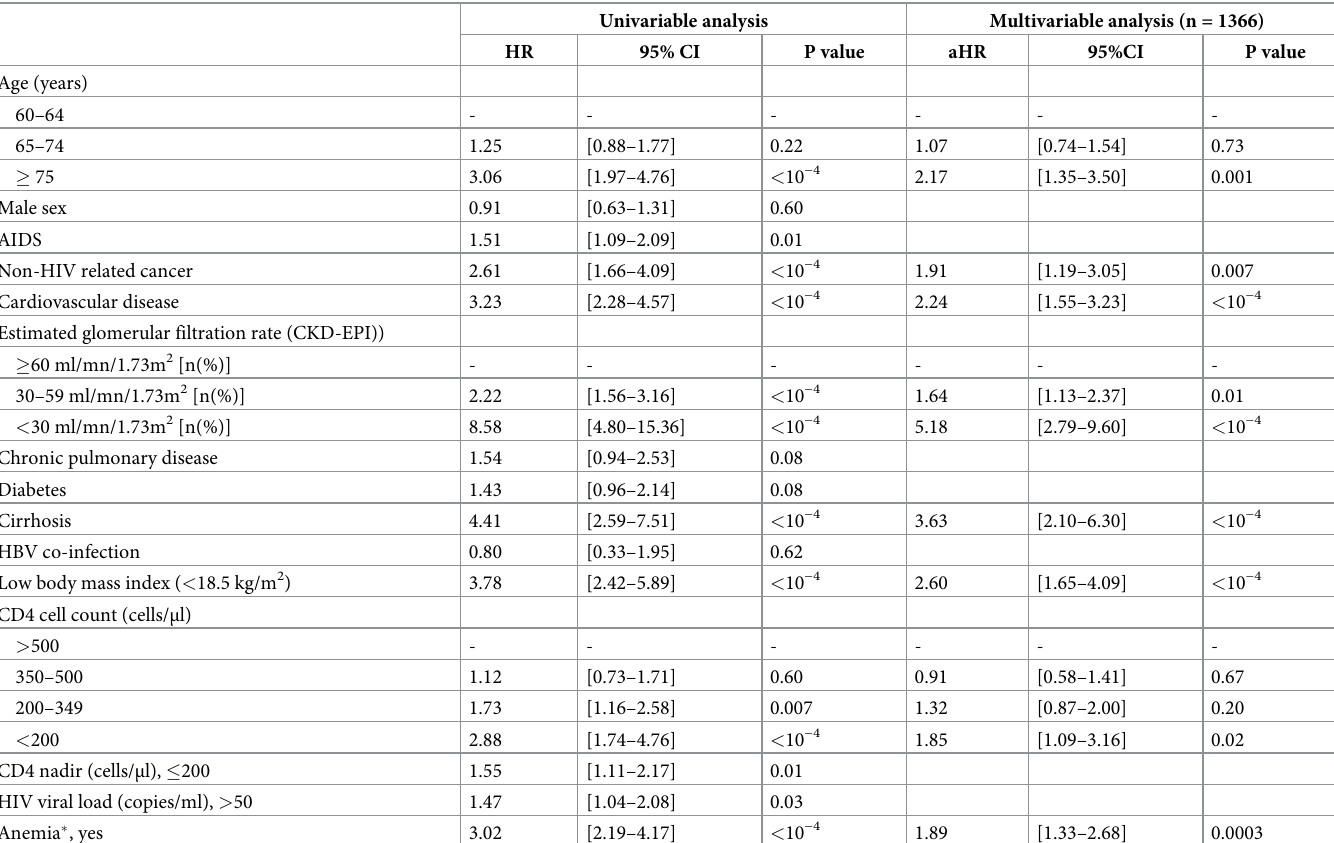
Table 2. Factors associated with overall 5-year mortality among PLHIV aged 60 years or over by univariable and multivariable analysis (N =